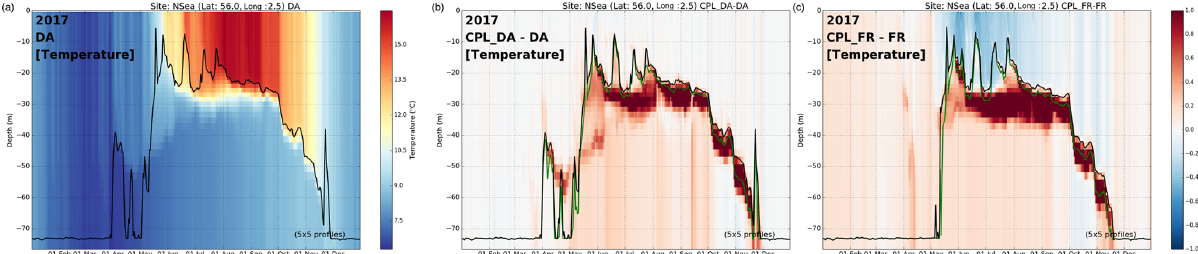
Figure 8. Evolution of daily mean temperature profiles through 2017 at a central North Sea location (see Fig. 3a). Temperature differences due to wave coupling are shown in (b) between CPL_DA and DA and in (c) for CPL_FR and FR. The lines plotted show MLD for simulations without wave coupling in black and with wave coupling in green.